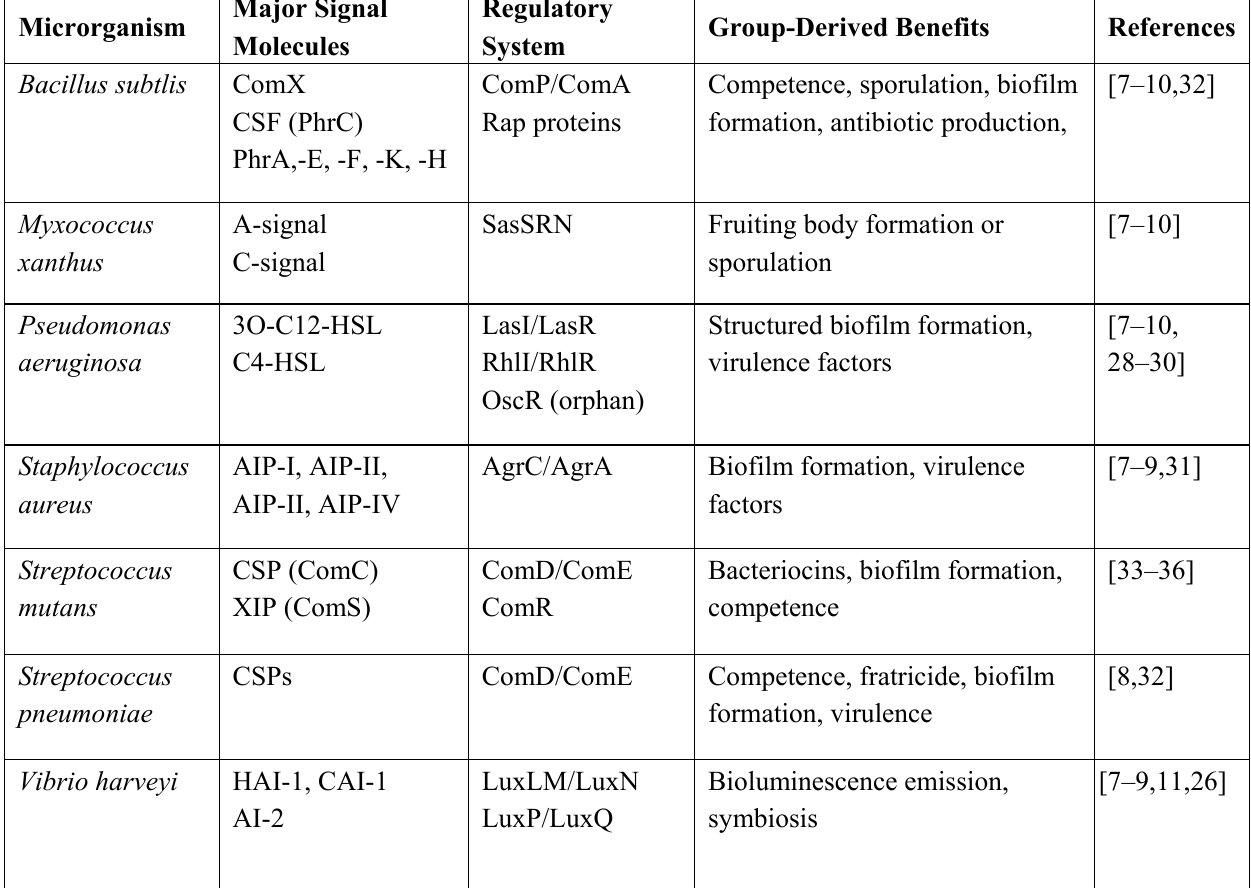
Table 1. Examples of Bacterial Quorum Sensing Systems and their Controlled Social Traits